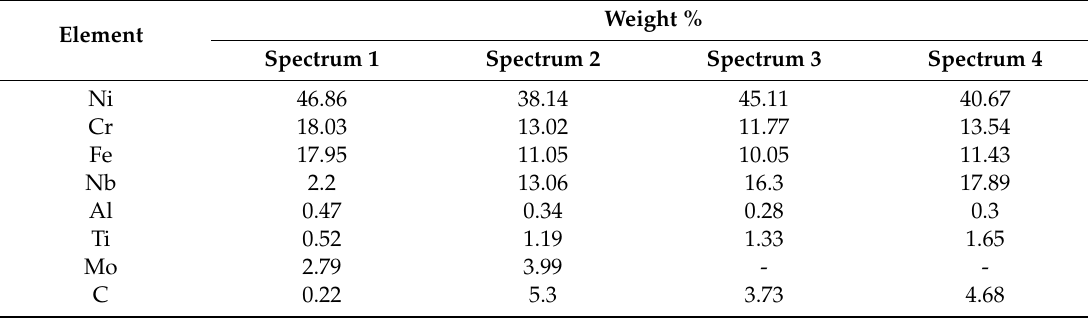
Table 4. Elemental analysis of point spectrum locations depicted in Figure